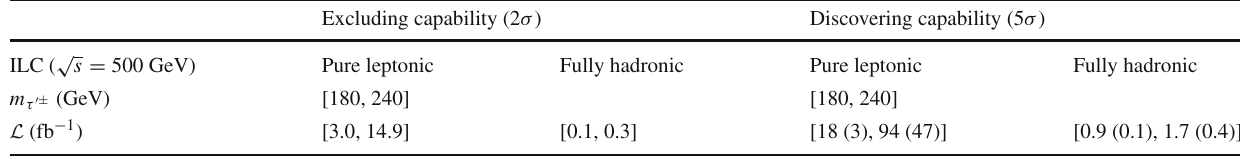
Table 12 Comparison of the excluding and discovering capability in the pure leptonic and the fully hadronic decay channels of electroweak gauge √ s = 500 GeV at ILC. The numbers in parentheses indicate the uncertainties of integrated luminosity bosons for